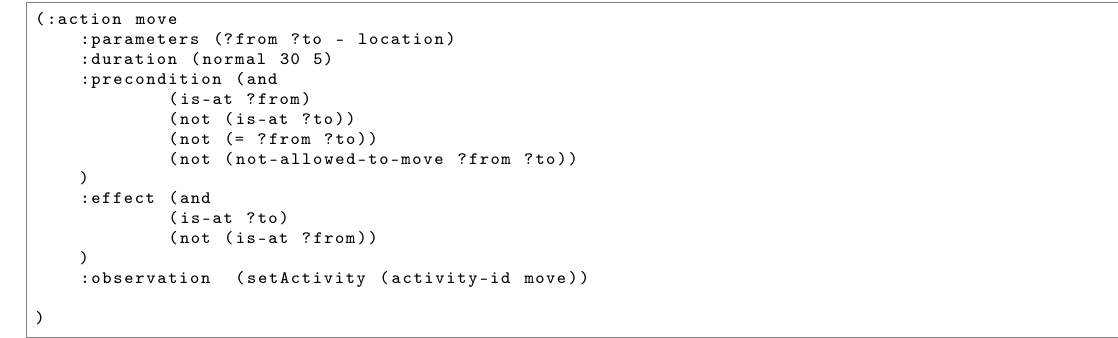
Figure 3. Example rule for the execution of the action